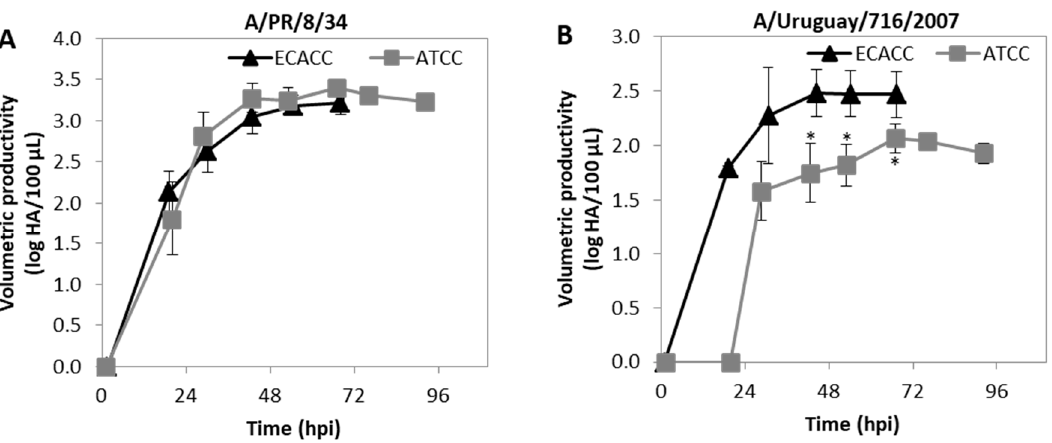
Figure 11. Progression of influenza A virus (IAV) infection in MDCK cells from ATCC or ECACC in suspension cultures of AEM medium. Volumetric titer of total particles (HA titers) over time of ( A ) A/PR/8/34 influenza virus strain and ( B ) A/Uruguay/716/2007 influenza virus strain. Cells were infected at MOI 10 − 5 . Values are shown as average ± standard-deviation ( n = 3). * p < 0.05, given by a Welch’s t -test comparing values obtained at the same time point.